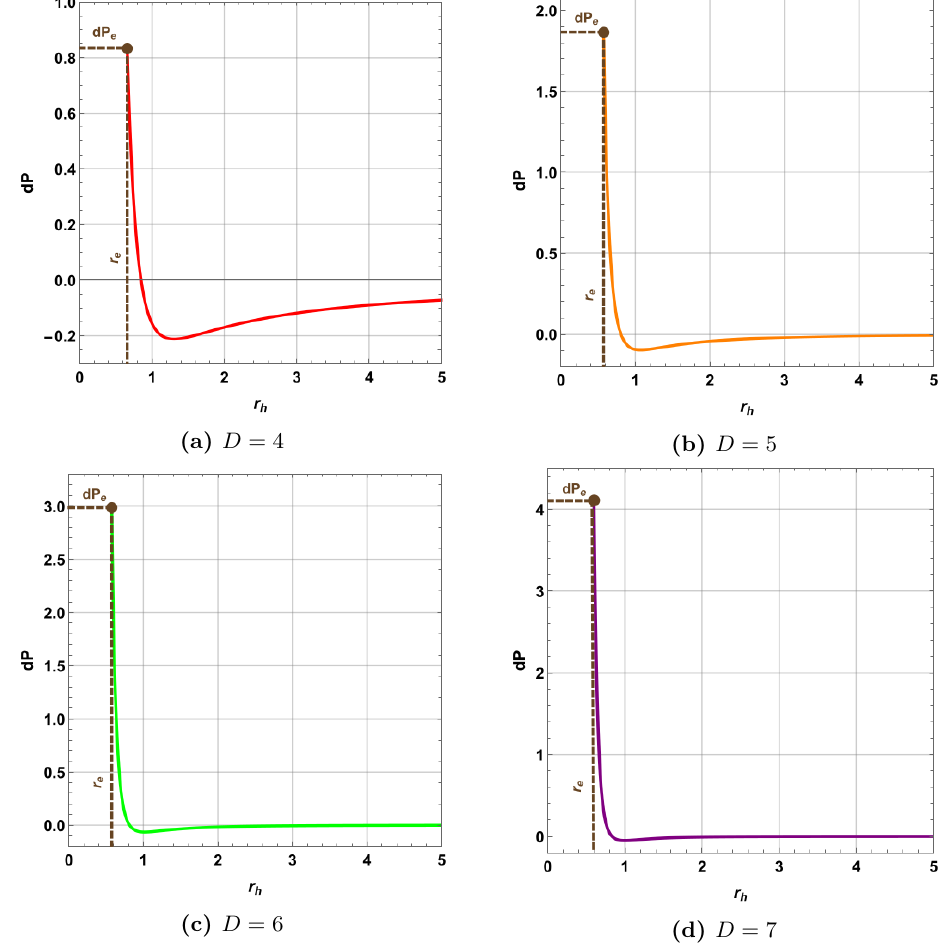
Figure 4. Pressure variation dP as a function of event horizon radius r h for different dimensions with | p r | = 1 , Q = 1 , l = 1 and dQ = 0 . 1 h